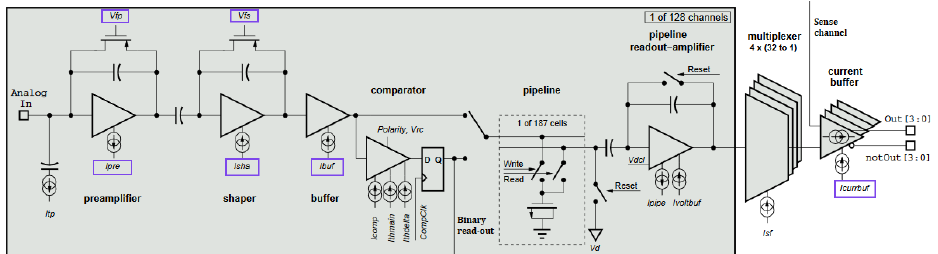
Figure 2. Single channel circuit scheme of the Beetle chip. The bias voltages and currents related to the analogue pulse shape are indicated by violet rectangles